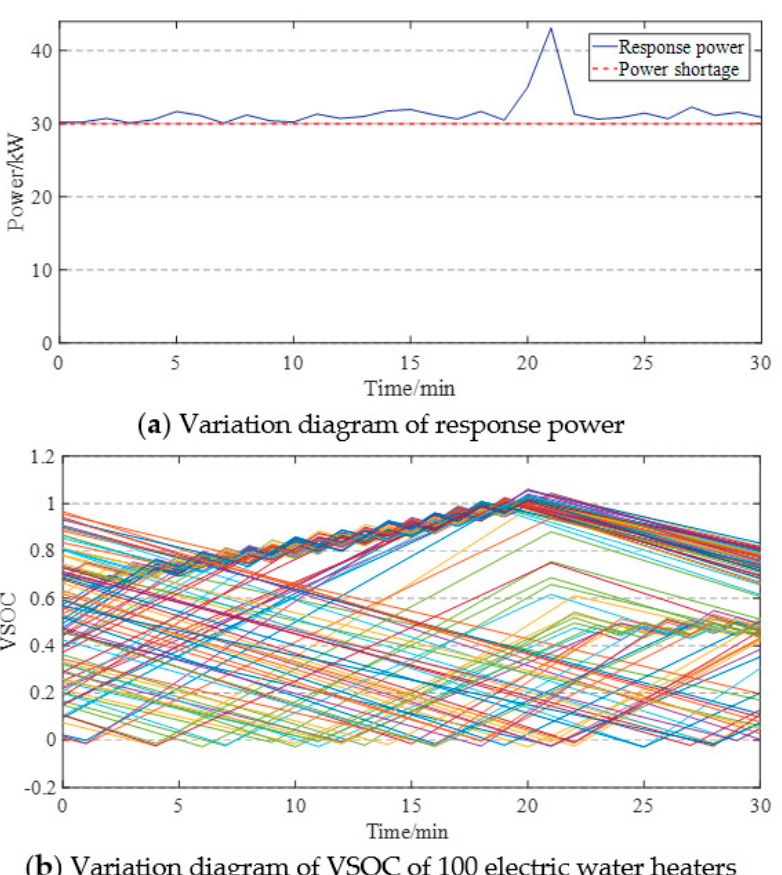
Figure 8. The response variation of power and VSOC in 30 min.